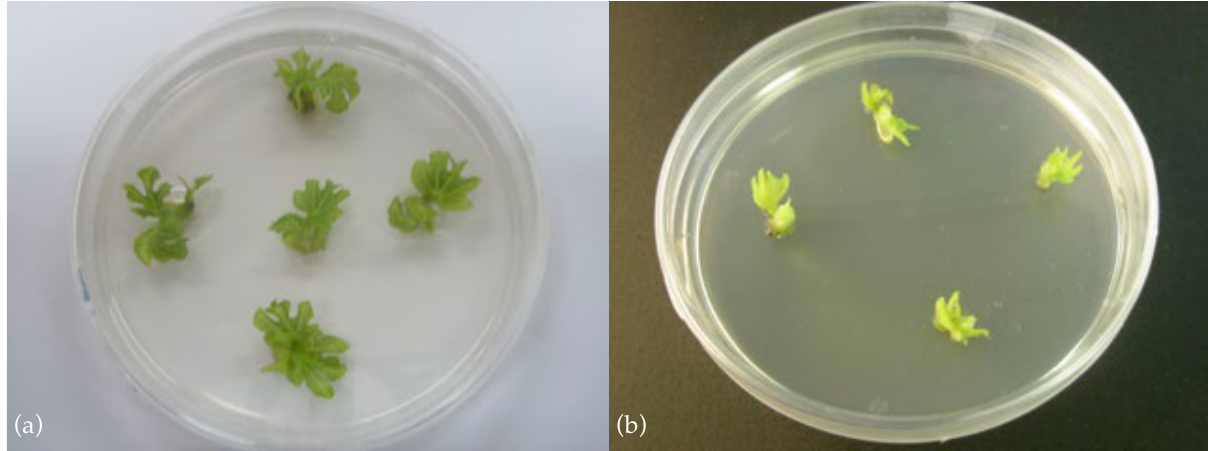
Figure 1. (a) Fig variety Aswad regenerated plants from stem cutting culture with thermotherapy. (b) Fig variety Biadi re- generated plants from shoot tip culture.